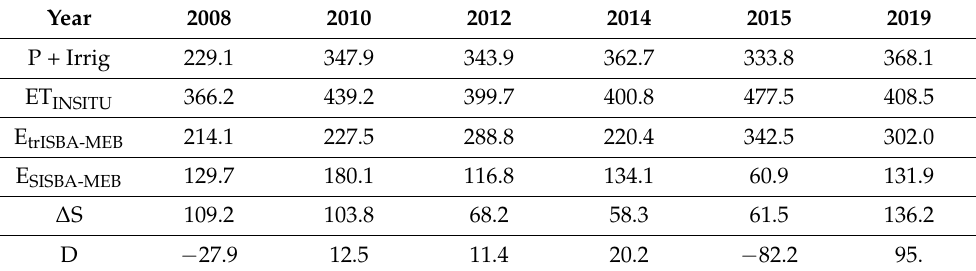
Table 7. Cumulated water inputs (P + Irrig), measured evapotranspiration (ET INSITU ), simulated transpiration (E trISBA-MEB ), soil evaporation (E SISBA-MEB ), the computed change in the soil water storage ( ∆ S), and the seepage/extraction (D) beyond 50 cm depth. All measurements are in